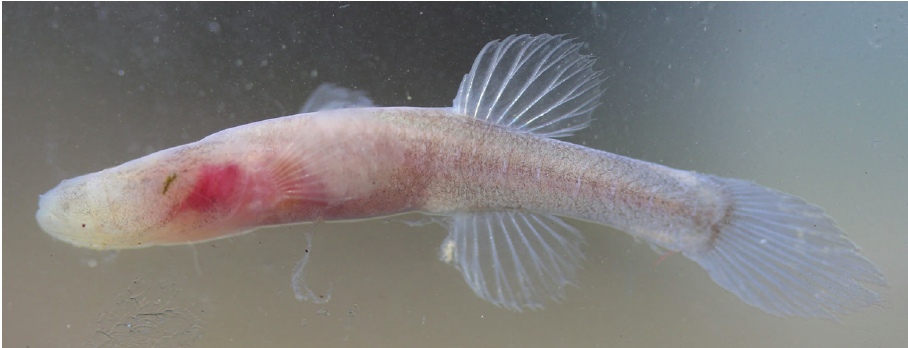
Figure 1. Typhlichthys subterraenus collected 25 November 2015 from Crane Cave (GCZ80), Catoosa County, Georgia. Photograph by B.R.